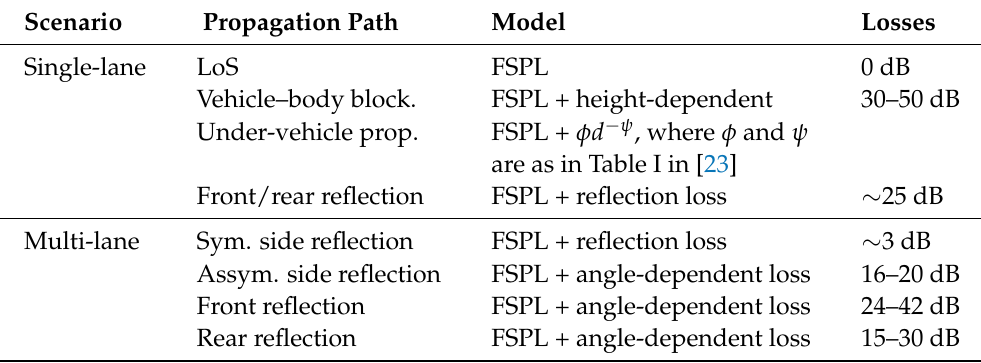
Table 1. Propagation losses, L B